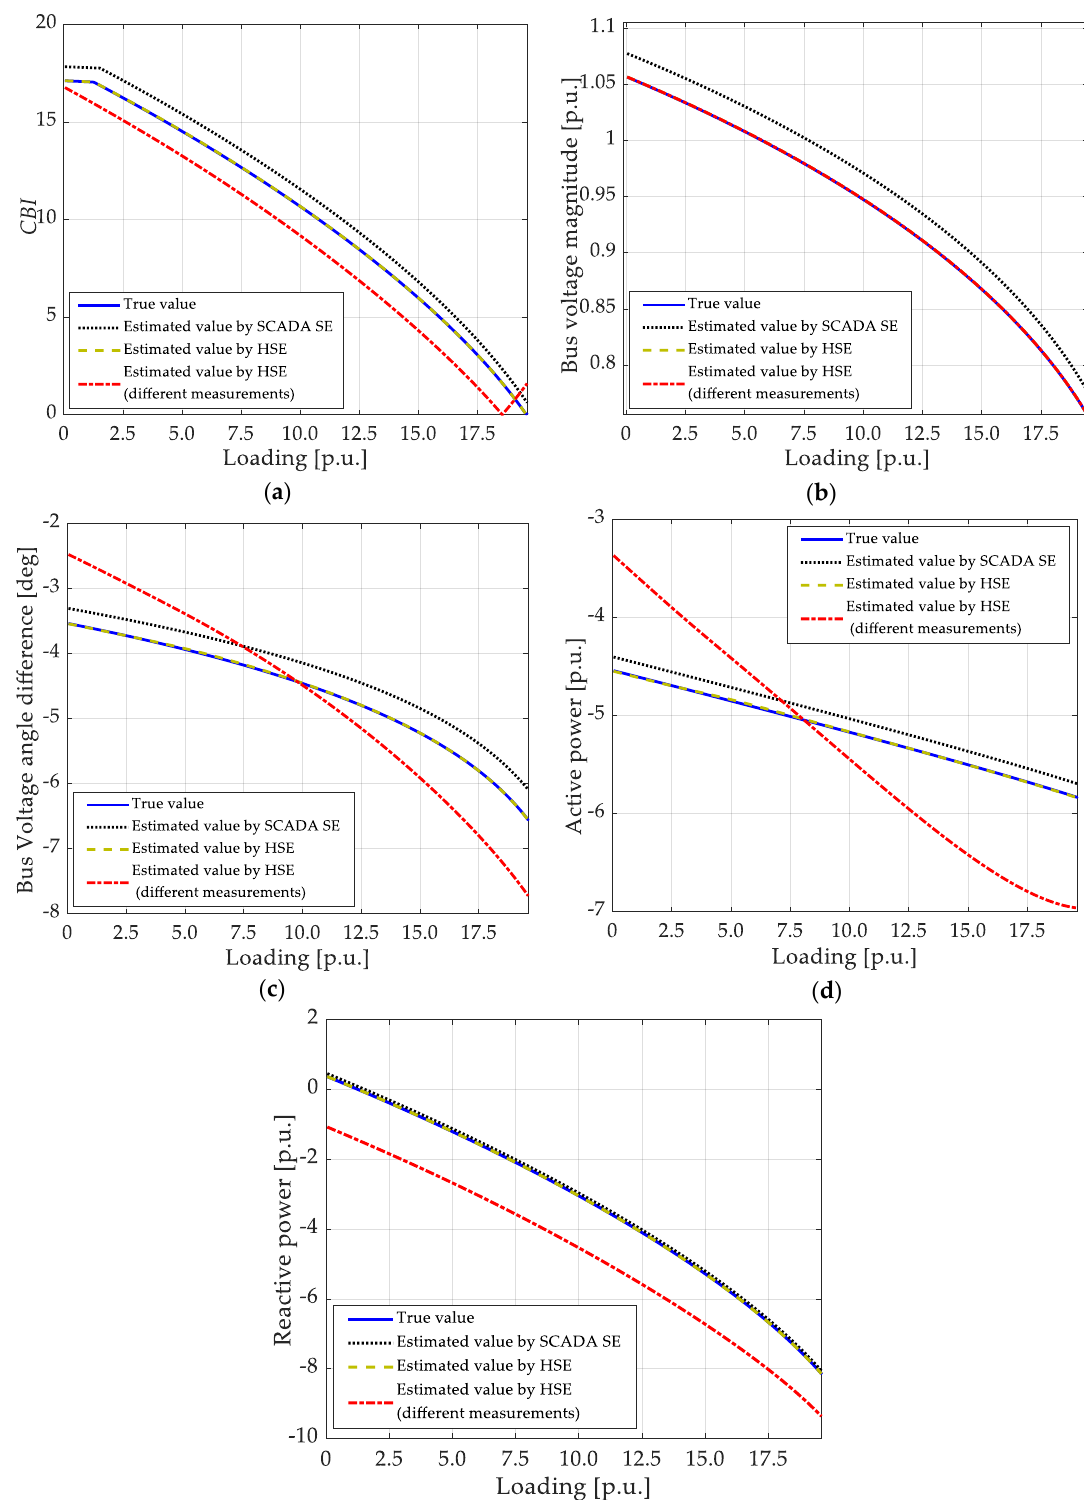
Figure 9. CBI in case of bus 38 loading. ( a ) CBI on line 38–39, ( b ) Voltage magnitude at bus 38, ( c ) Voltage angle di ff erence between buses 38 and 39, ( d ) Active power at receiving end on line 38–39, ( e ) Reactive power at receiving end on line